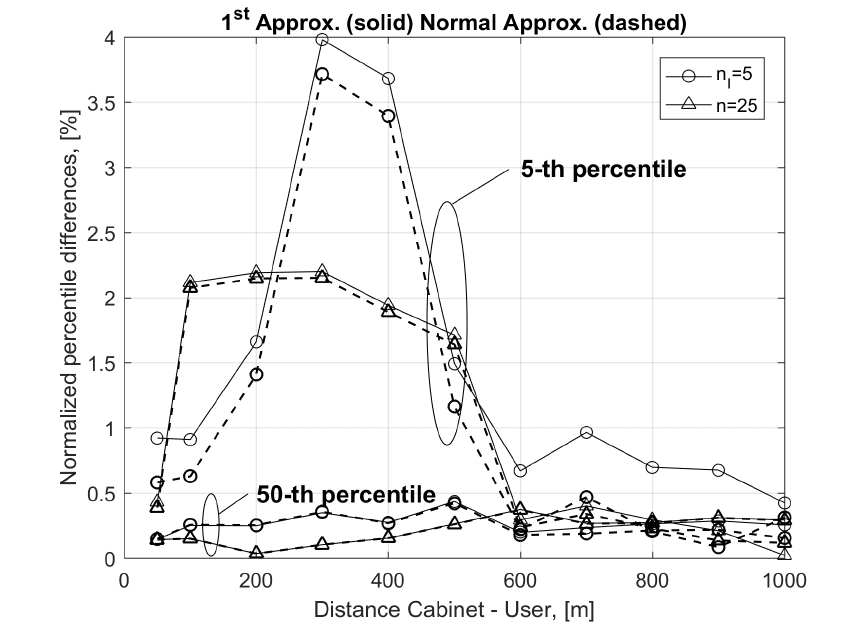
Figure 3. Differences (normalized to the bit rate) between the 50th and 5th percentile, obtained with the two approximations with respect to the exact